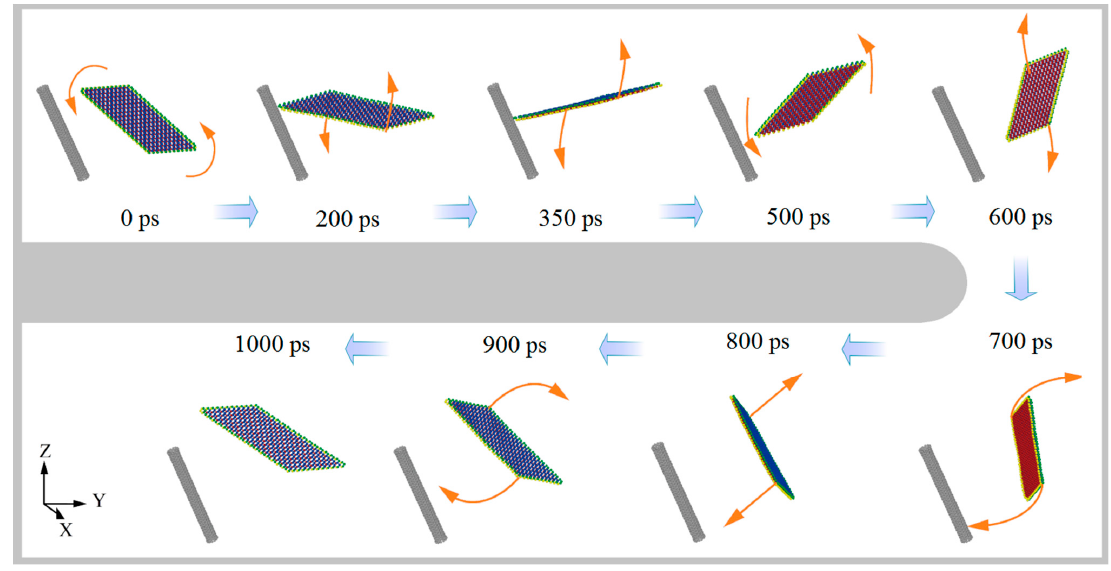
Figure 3. Some representative system configurations of “escape” with CNT (6, 6) when α = 30° and L y = 0.